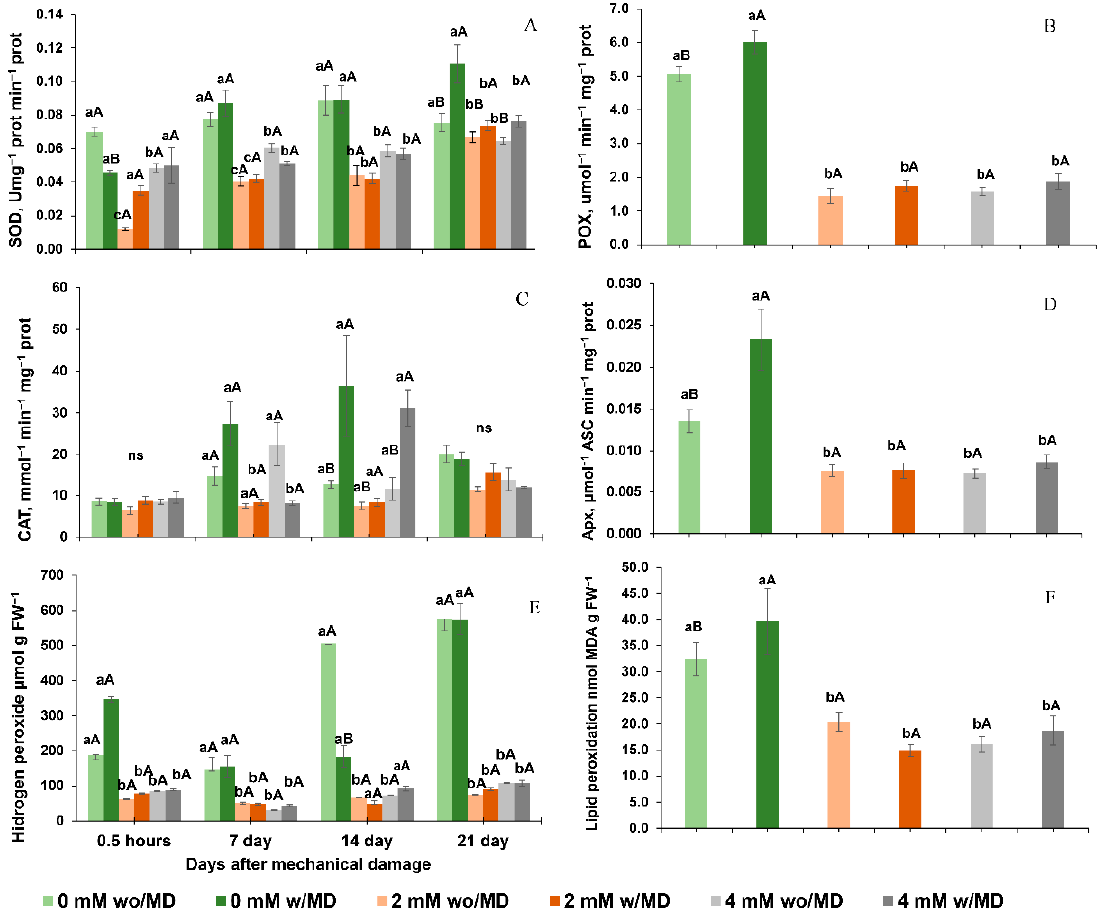
Figure 2. Activity of antioxidants ( A ). Superoxide dismutase (SOD) time × damage × calcium p < 0.001, ( B ). Peroxidase (POX) damage × calcium p < 0.045 and ( C ). Catalase (CAT) time × damage × calcium p < 0.033 and ( D ). Ascorbate peroxidase (APX) damage × calcium p < 0.006, ( E ). Hydrogen peroxide (H 2 O 2 ) concentration time × damage × calcium p < 0.001 and ( F ). Lipid peroxidation (expressed by the formation of malonaldehyde, MDA) damage × calcium p < 0.017, in Solanum lycopersicum “cv. Micro-Tom” grown with variation in calcium concentration (mM) and with (w/MD) or without (wo/MD) mechanical damage. Different lowercase letters indicate a significant difference in calcium levels within wo/MD or w/MD plants. Capital letters test wo/MD and w/MD plants within the same calcium level. ns = not significant at 5% Tukey test. Bars correspond to averages, whiskers to ± SE ( n =